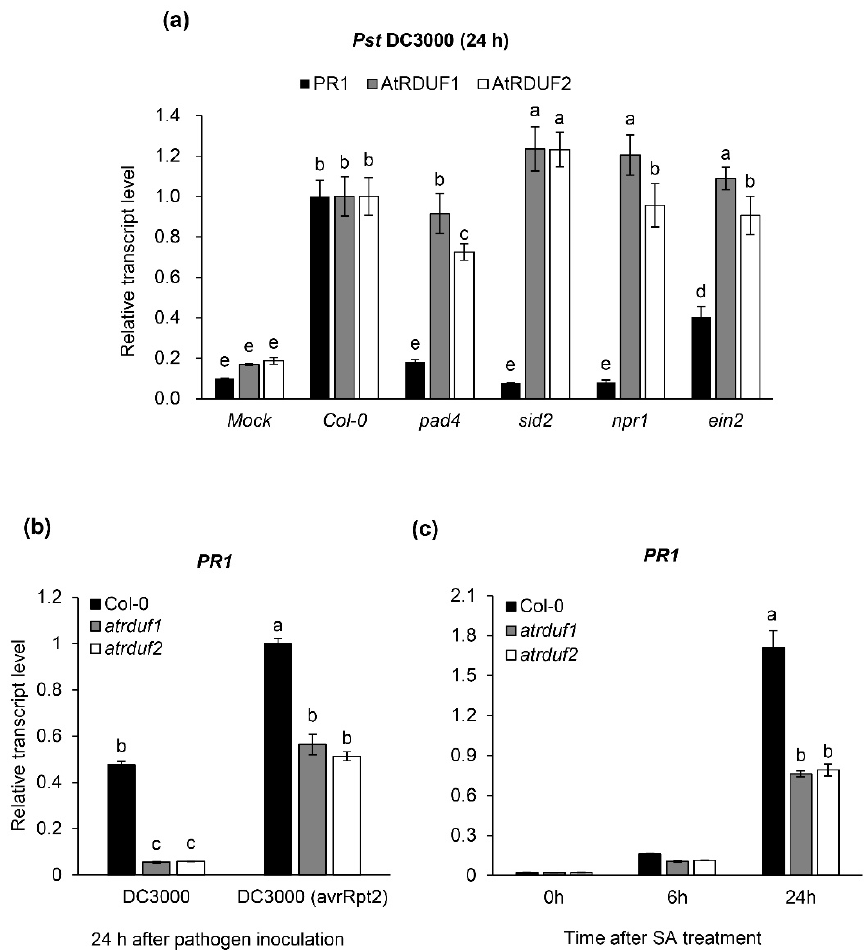
Figure 3. AtRDUF1 or AtRDUF2 are required for inducing PR1 expression by pathogen or salicylic acid (SA). ( a ) Levels of PR1 , AtRDUF1 , and AtRDUF2 transcripts were determined by quantitative reverse transcription polymerase chain reaction (qRT-PCR) in leaves of 5-week-old wild-type (WT) control, pad4 , sid2 , npr1 , and ein2 mutants with transcript level normalized against that of ACT2 . Leaves of Arabidopsis were harvested 24 h post inoculation for extracting total RNA. Error bars represent standard deviations of three replications. Similar results were obtained in at least three independent experiments. Different letters indicate significant differences among plant genotypes after inoculation ( α = 0.05, one-way ANOVA and Tukey’s HSD test; JMP software). ( b ) The transcript levels of PR1 were determined using quantitative reverse transcription polymerase chain reaction (qRT-PCR) in leaves of 5-week-old wild-type (WT) control, atrduf1 , and atrduf2 mutants with transcript levels normalized against those of ACT2 . Leaves of Arabidopsis were harvested 24 h post inoculation with Pst DC3000 or Pst DC3000 ( avrRpt2 ) for extracting total RNA. Error bars represent the standard deviations of three replications. Different letters indicate significant differences among plant genotypes ( α = 0.05, one-way ANOVA and Tukey’s HSD test; JMP software). ( c ) Levels of PR1 transcript in wild-type (WT) and atrduf mutants after treatment with salicylic acid (SA) (1 mM). Leaves of Arabidopsis were harvested at 0, 6 h, and 24 h post treatment for extracting total RNA. Gene transcript levels were normalized to ACT2 transcript levels. Error bars represent the standard deviations of three replications. Different letters indicate significant differences among plant genotypes ( α = 0.05, one-way ANOVA and Tukey’s HSD test; JMP software).